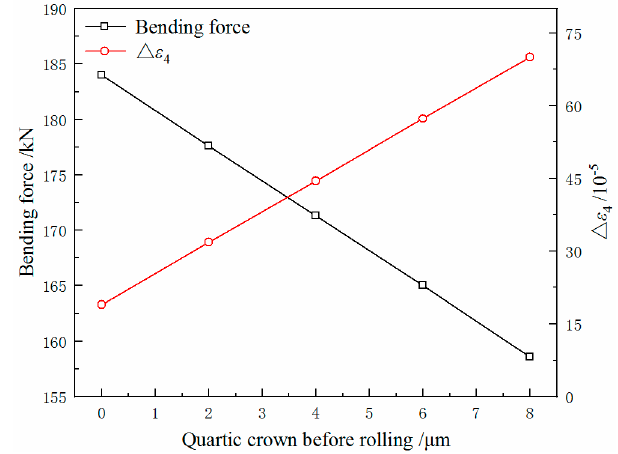
Figure 19 . Bending force and Δ ε 4 of the strip with different quartic crowns before rolling ( Δ T = 50 °C). Figure 19. Bending force and ∆ ε 4 of the strip with di ff erent quartic crowns before rolling ( ∆ T = 50 ◦